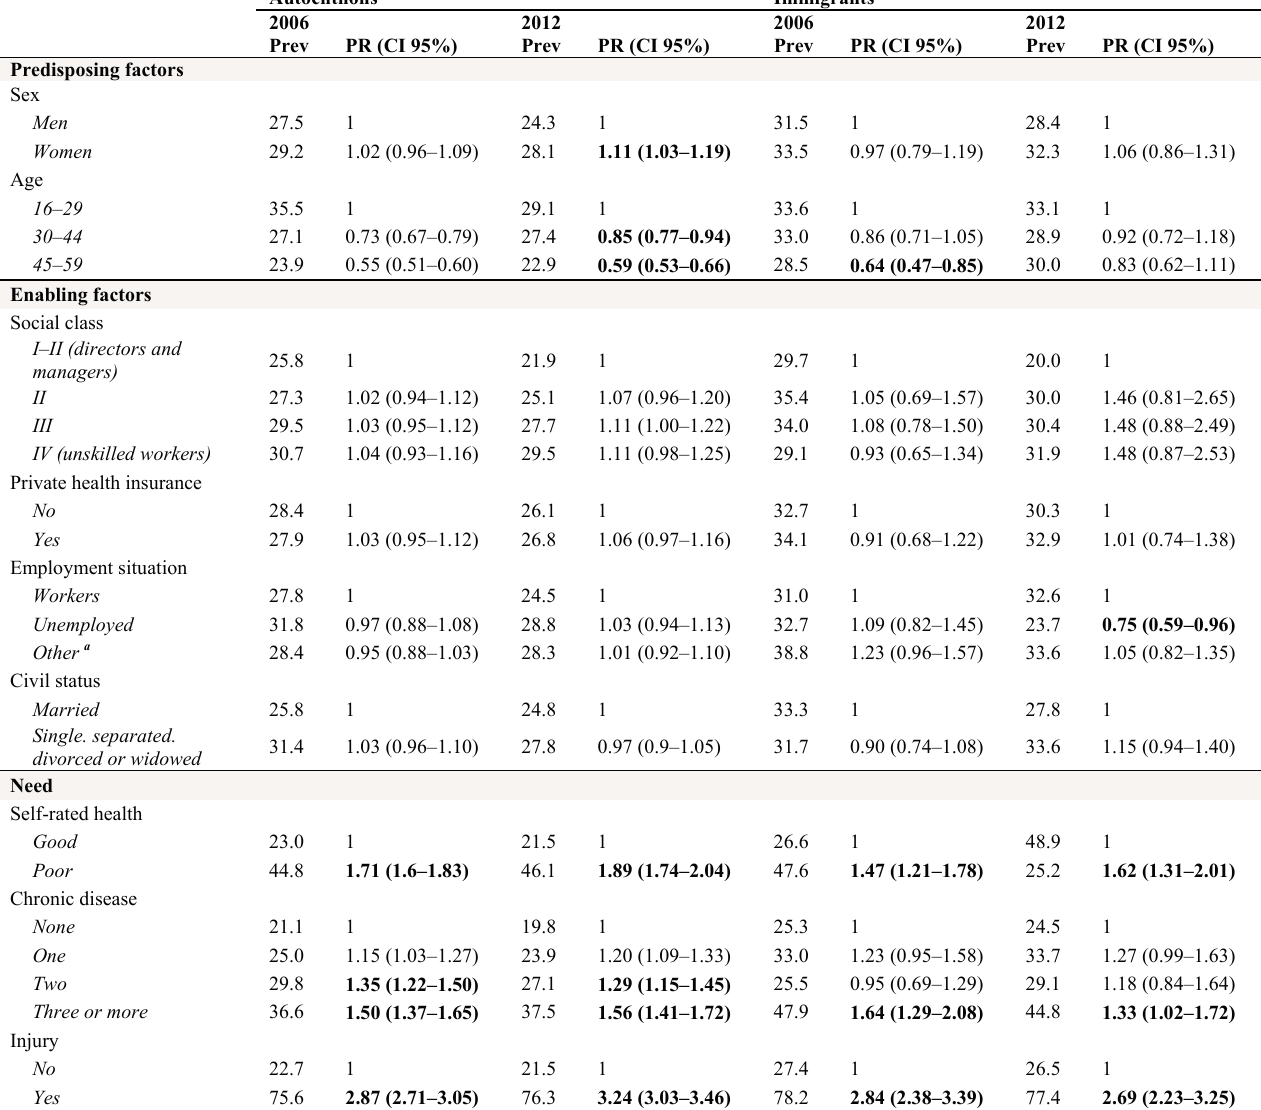
Table 6. Determinants of the use of emergency services in autochthons and immigrants in 2006 and